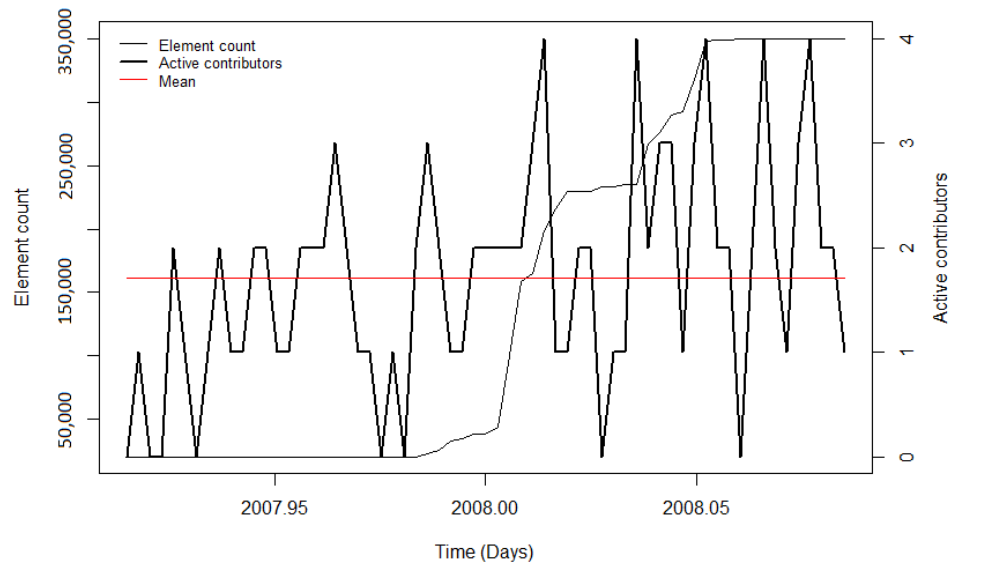
Figure A5. Contributor activity during the PGS